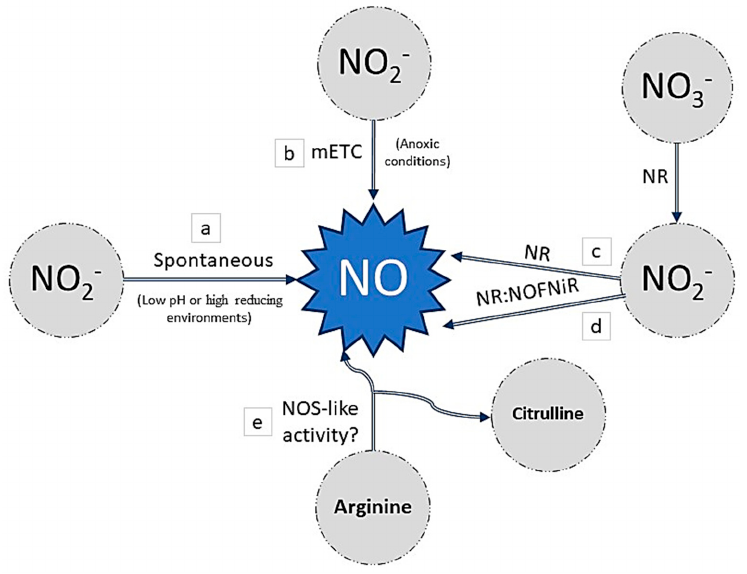
Figure 3. Nitric oxide (NO) synthesis in plants: ( a ) the non-enzymatically mechanism, under low pH or high reducing environments. ( b ) NO can be produced from nitrite through the action of the mitochondrial electron transport chain (mETC). ( c ) Nitrate reductase (NR) is responsible for the reduction of nitrate to nitrite using and then producing NO by Ni-NR activity. ( d ) NR can interact with the partner protein NOFNiR (nitric oxide-forming nitrite reductase) to produce NO from nitrite. ( e ) Arginine-dependent pathway in plants forms NO by NOS (nitric oxide synthase)-like activity.